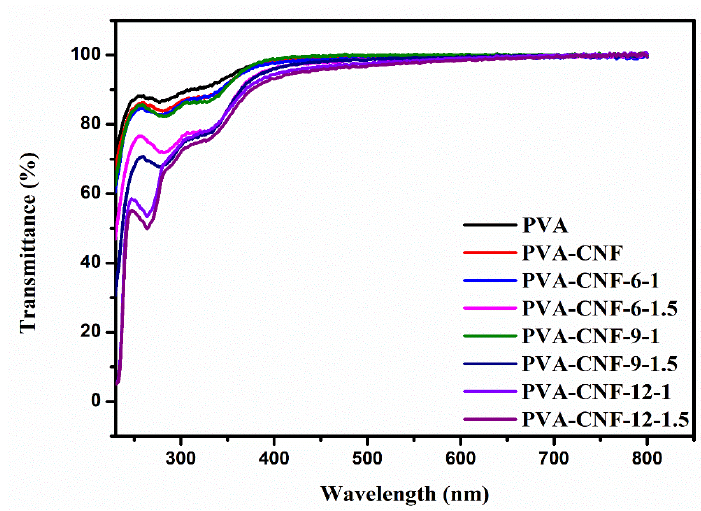
Figure 7. UV-Visible transmittance of neat PVA and PVA/CNF films.